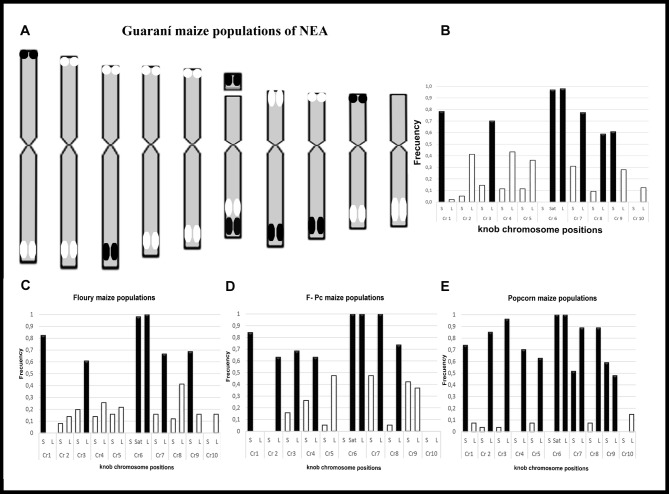
Consensus idiogram and knob position histogram of Guaraní maize of NEA, where the position, average size and frequency of each knob are indicated.(A) Consensus idiogram of Guaranís maize from NEA. (B) Knob position histogram. (C-E) Knob position histograms for maize population with different types of grains, Floury-F (C), Floury grains with corneal periphery-F-Pc (D) and Popcorn-P populations (E). Ref. The position, average size and knob frequencies are indicated on the idiogram. The average size of the knobs are represented by the size of the bands (Sk, Mk and Lk). The black blocks/ bars indicate the most frequent positions (f ≥0.6). The white blocks/ bars show positions of less frequency (f<0.6). The size of each knob was estimated in relation to thechromosome length: small knobs (Sk) ≤ 10%, medium knobs (Mk) between 10% and 20%, and large knobs (Lk) ≥ 20%. Cr: chromosomal pair. L: long arm. S: short arm. Sat: satellite region.